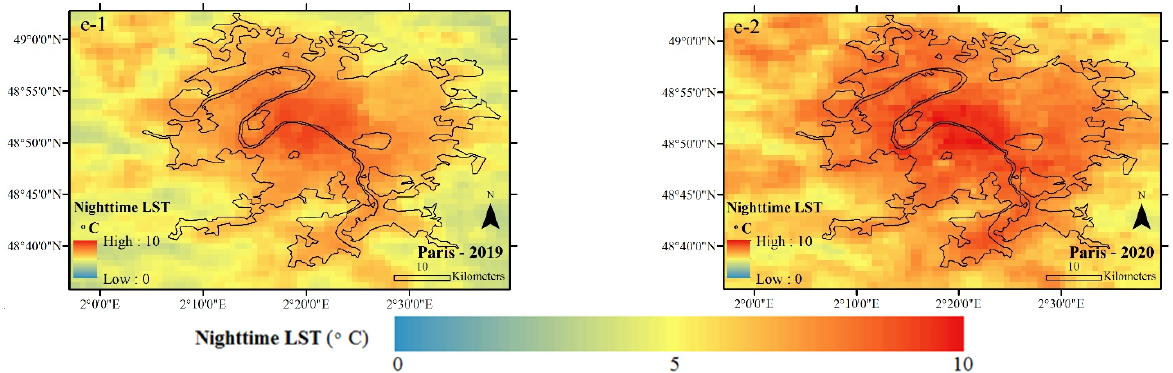
Figure 5. Average NLST of the studied cities during CSR, extracted from MOD11A2 data in °C. ( a-1 ) Average NLST of Berlin in 2019, ( a-2 ) Average NLST of Berlin in 2020, ( b-1 ) Average NLST of Frankfurt in 2019, ( b-2 ) Average NLST of Frankfurt in 2020, ( c-1 ) Average NLST of London in 2019, ( c-2 ) Average NLST of London in 2020, ( d-1 ) Average NLST of Madrid in 2019, ( d-2 ) Average NLST of Madrid in 2020, ( e-1 ) Average NLST of Paris in 2019, ( e-2 ) Average NLST of Paris in 2020.